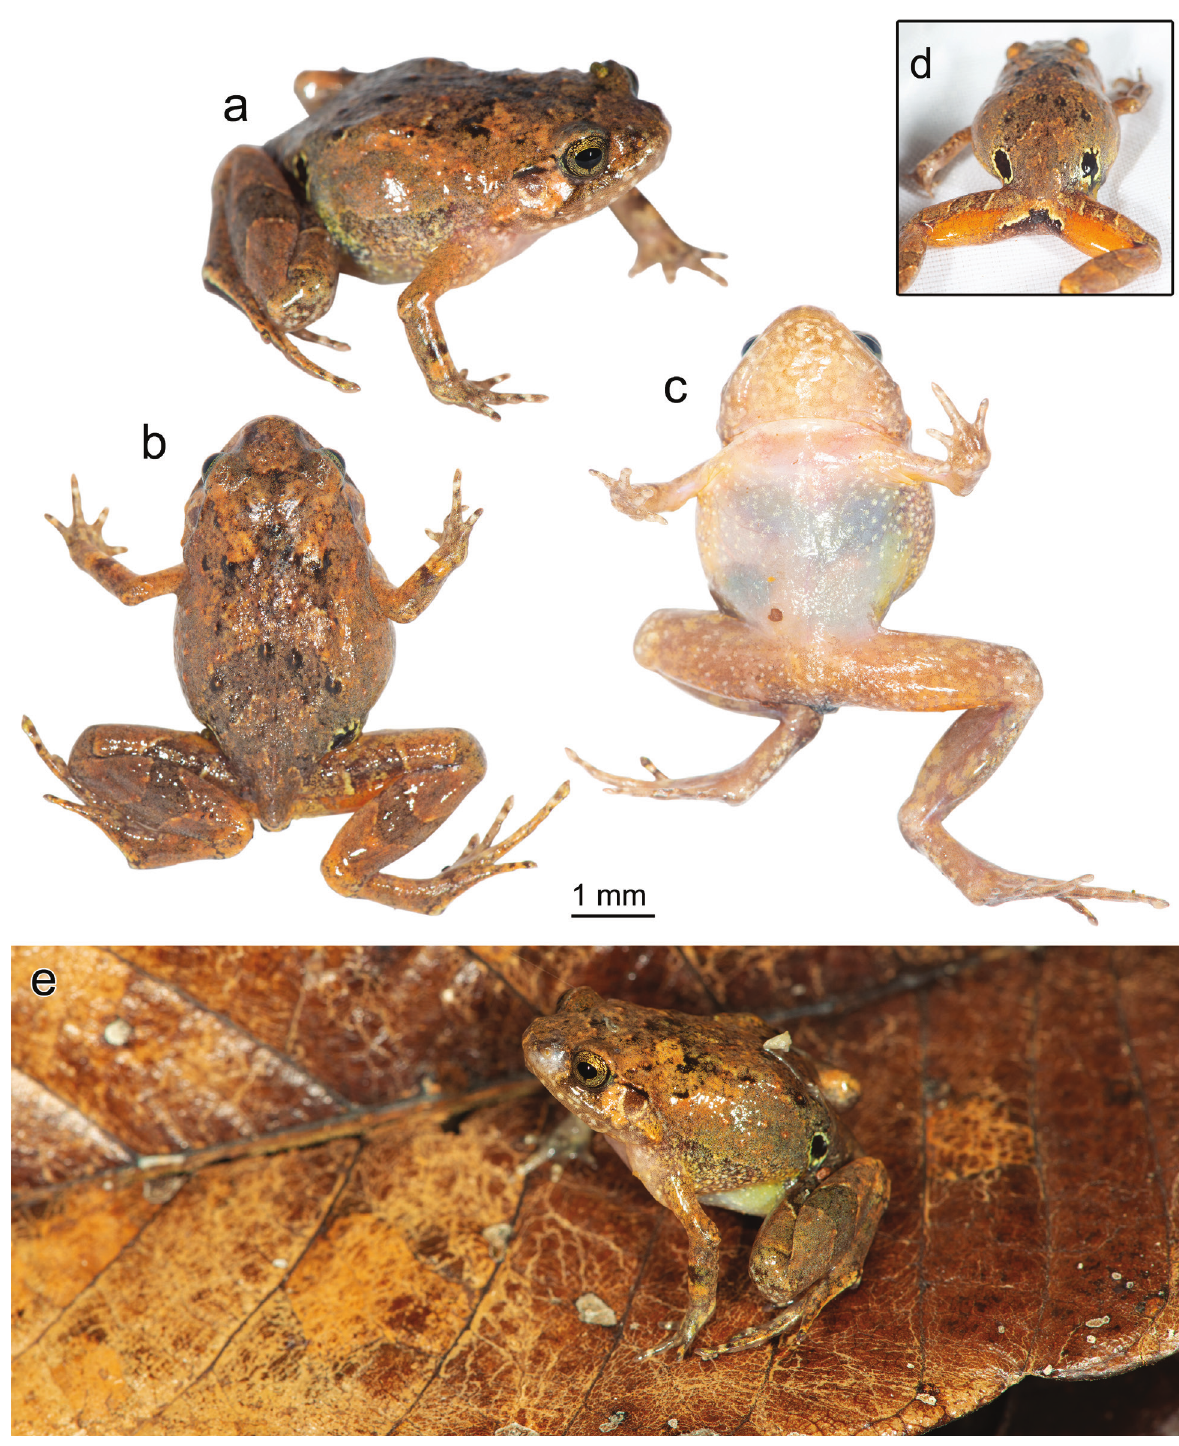
Figure 2. The holotype of Rhombophryne ellae sp. nov. in life. a. In dorsolateral view; b. In dorsal view; c. In ventral view; d. In posterior view showing the orange flash-markings on the thighs and the distinctive inguinal spots; e. On leaf